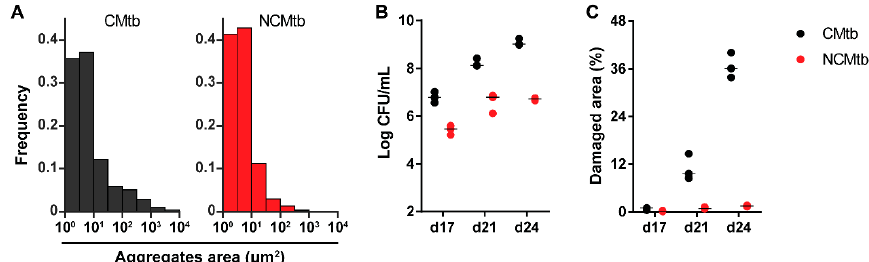
Figure 1. Impact of cording bacilli challenge on the progression towards active tuberculosis (TB). ( A ) Aggregate area distribution pattern for both batches. Each column represents the frequency of spots for each area interval, logarithmically distributed between 1 and 10 4 µm 2 . ( B ) Bacillary load (BL) and ( C ) damaged lung area progression after intravenous (IV) challenge with cording Mtb(CMtb) or non-cording Mtb(NCMtb).